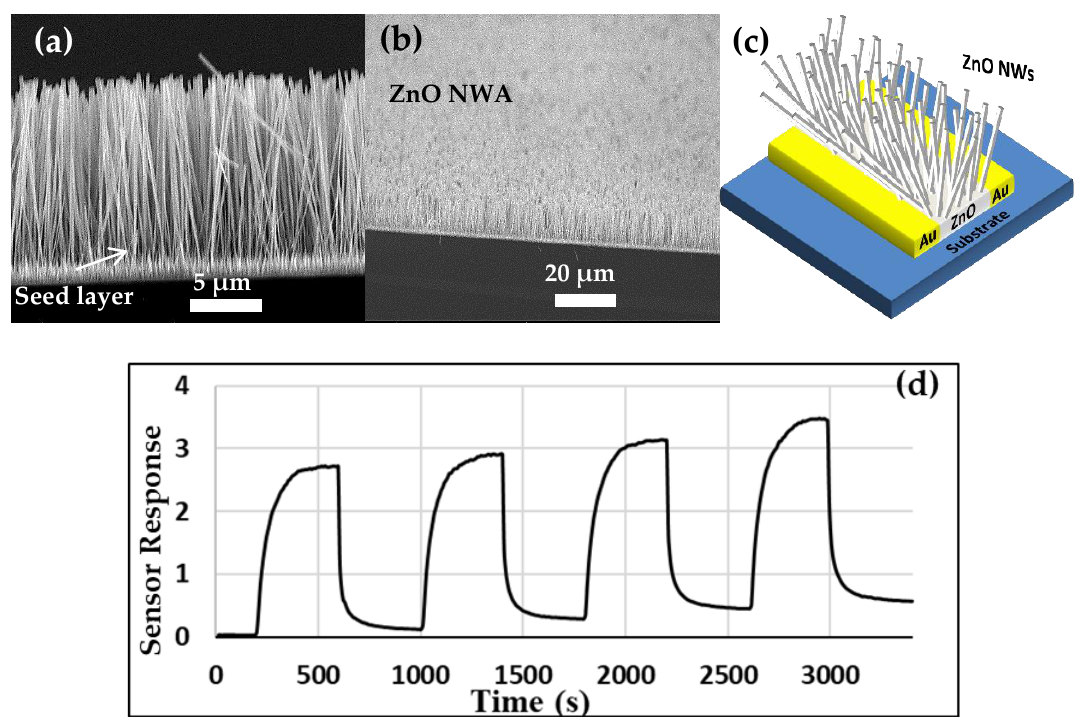
Figure 2. ( a , b ) SEM images, ( c ) a schematic diagram, and ( d ) the gas sensing characteristics of the ZnO NWA sensor to 200 ppm of acetone.